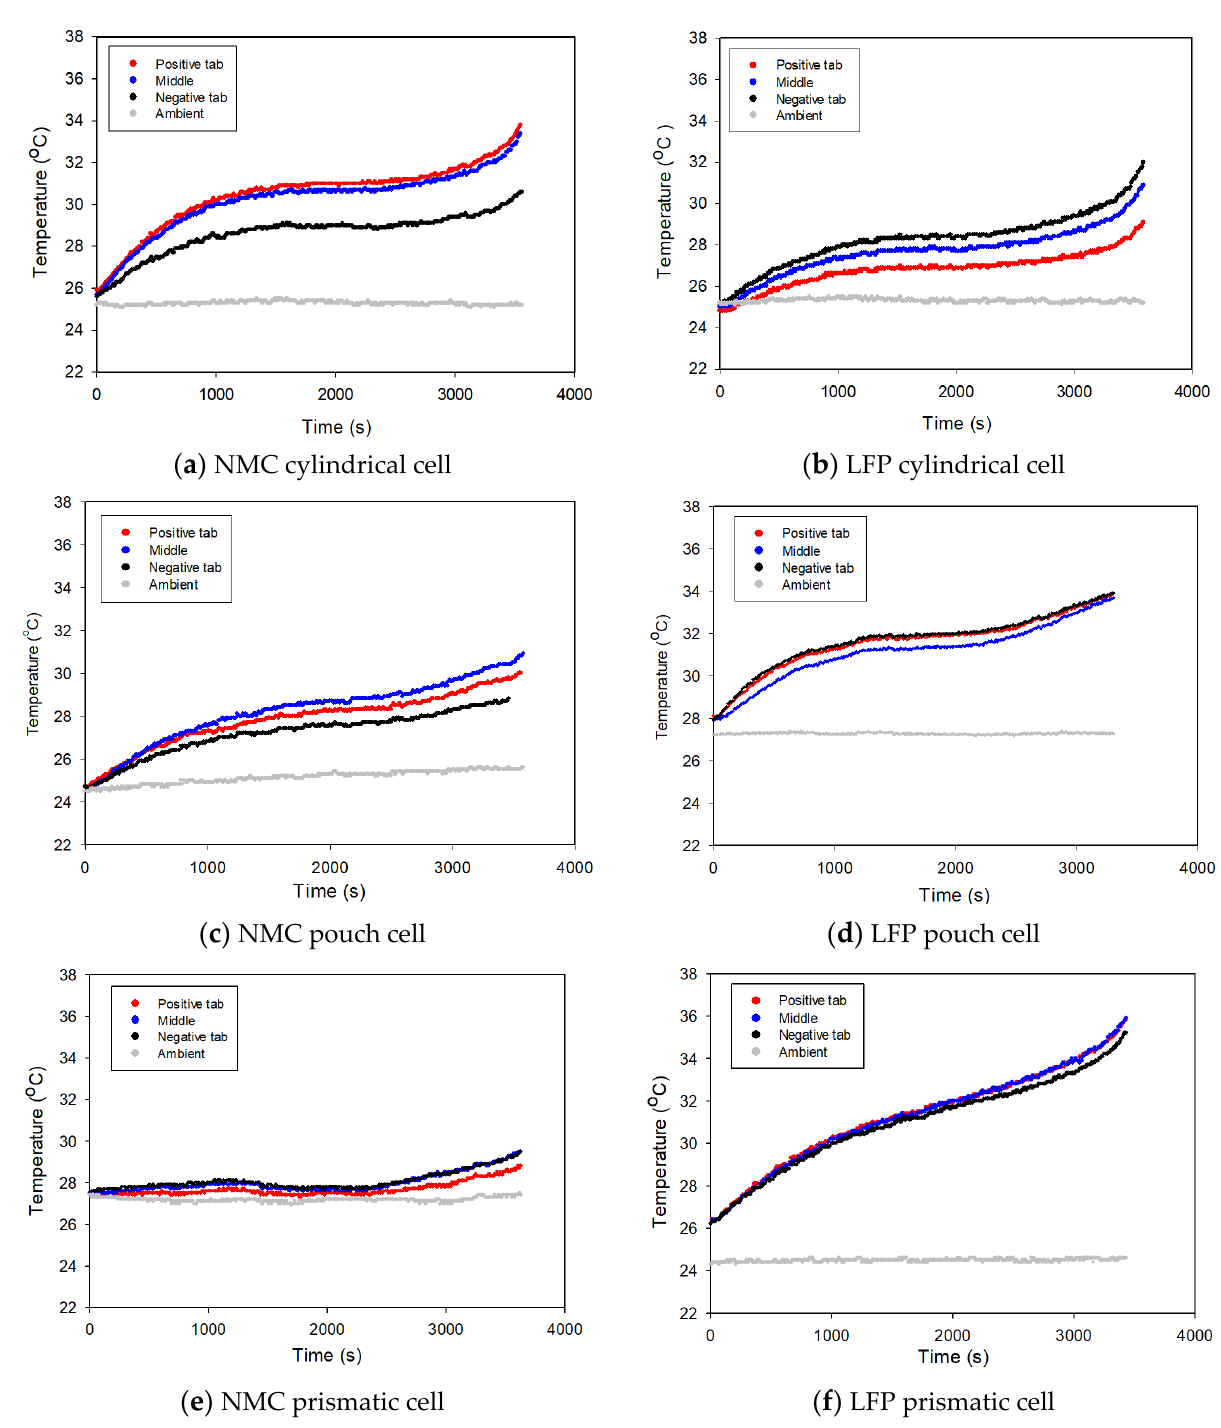
Figure 9. The experimental results of battery temperature located at three positions (body, negative tab, and positive tab) during the discharge rate of 1C: ( a ) NMC cylindrical, ( b ) LFP cylindrical, ( c ) NMC pouch, ( d ) LFP pouch, ( e ) NMC prismatic, and ( f ) LFP